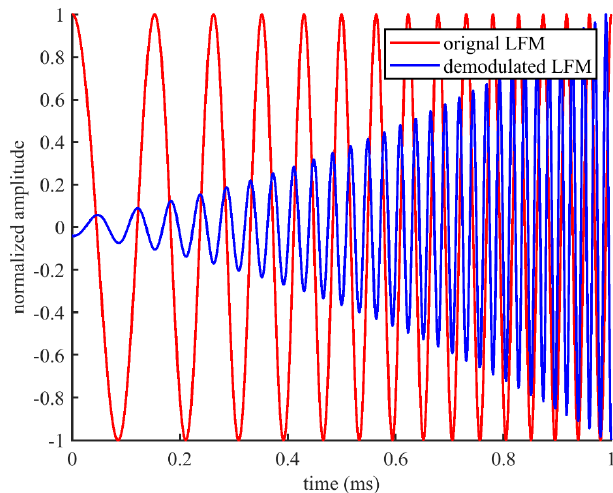
Figure 2. Comparison of the original linear frequency modulated (LFM) and self-demodulated LFM in time domain.